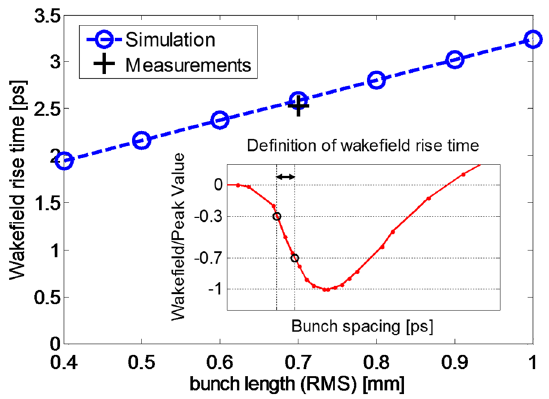
FIG. 11. Rise time of measured and simulated